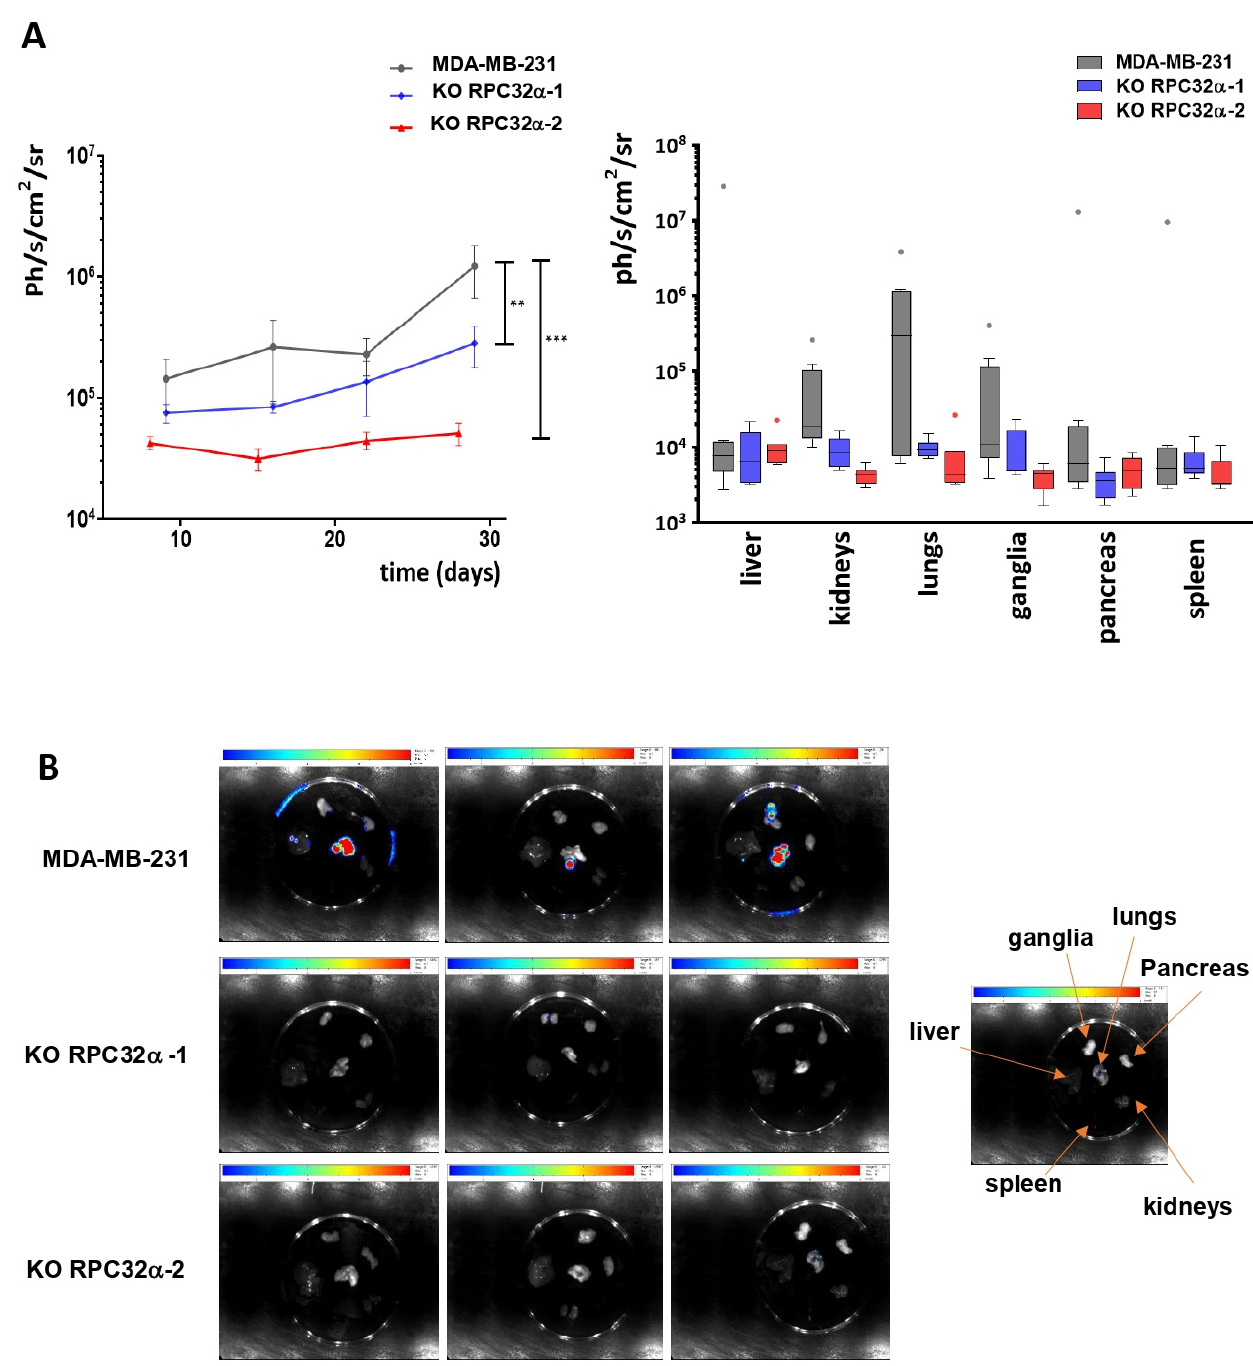
Figure 7. Analyses of metastases formed by MDA-MB-231 and POLR3G KO (3GKO) cell lines. ( A ) To the left, logarithmic representation of overall metastases bioluminescence ± SEM (** p < 0.001; *** p < 0.001) (MDA-MB-231: number of mice analyzed ( n ) = 9, KO RPC32 α -1: n = 7, KO RPC32 α - 2: n = 7). To the right, logarithmic representation of metastases luminescence in distinct organs (liver, kidneys, lungs, ganglia, pancreas and spleen, as shown below the graphs). ( B ) Representative images of bioluminescence imaging of different organs 4 weeks after resection of primary tumor. The localization of organs on images is shown to the right.